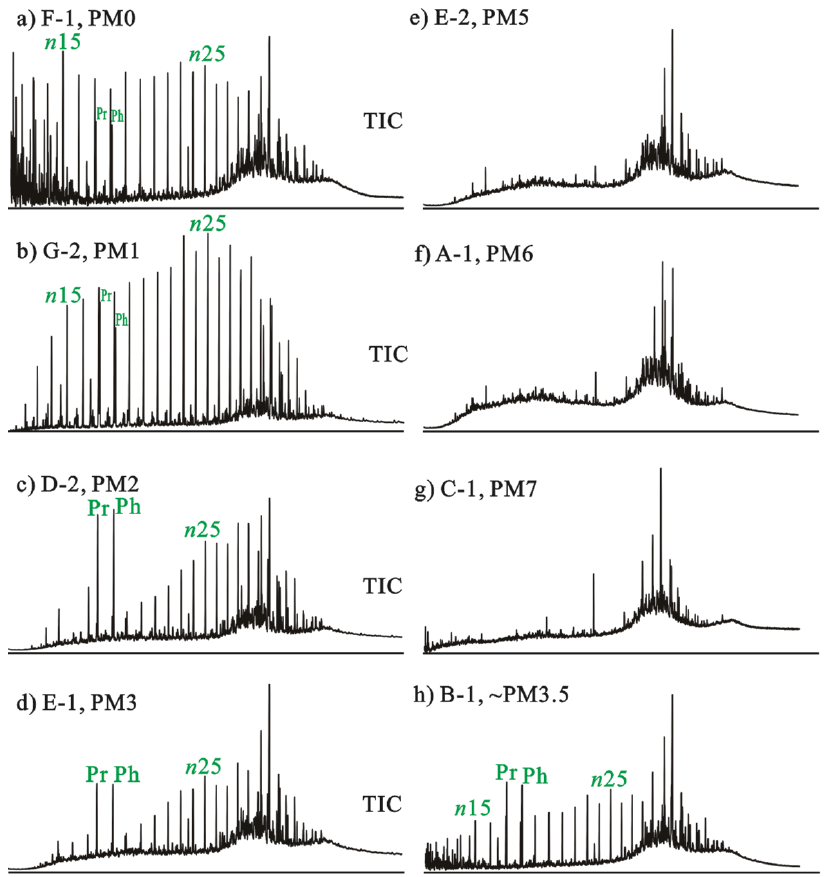
Figure 2. TIC chromatograms of selected oils with different degrees of biodegradation (PM Scale). Pr: Pristane; Ph: Phytane.